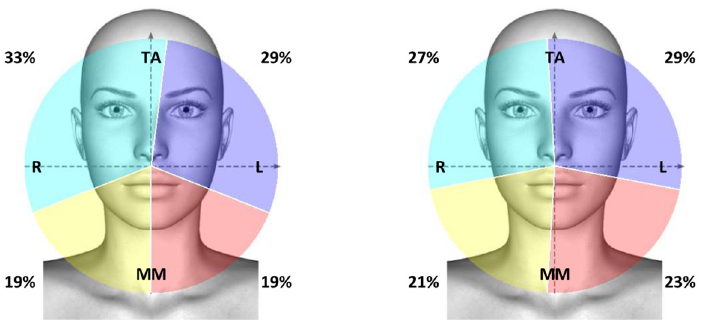
Figure 2. Graphic representation of the analyzed muscles, indicated by light blue and purple colors referring to the activity of right (R) and left (L) anterior temporalis muscles (TA), respectively, and by yellow and red referring to the activity of right (R) and left (L) masseter muscles (MM), respectively.